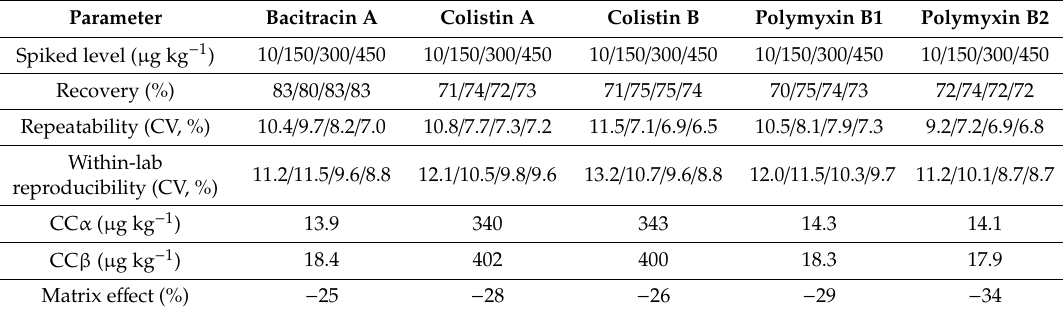
Table 3. Validation results of the method for the determination of polypeptides in